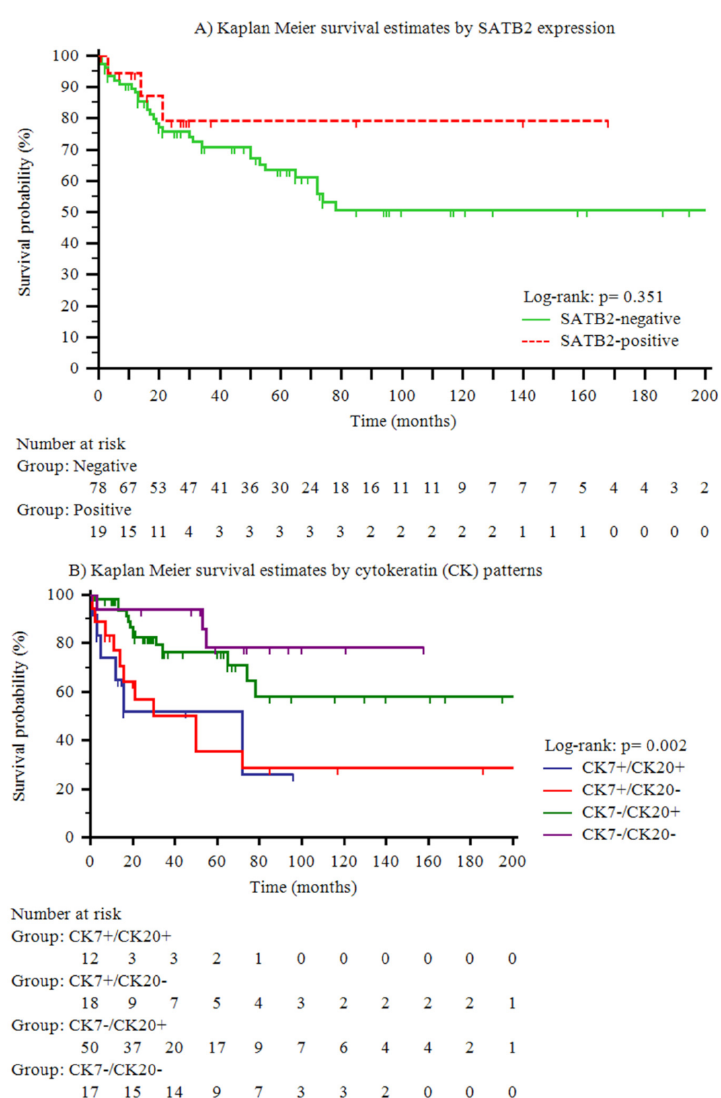
Figure 2. Kaplan–Meier cancer-specific survival estimates by special AT-rich sequence-binding protein 2 (SATB2) expression ( A ) and cytokeratin (CK) patterns ( B